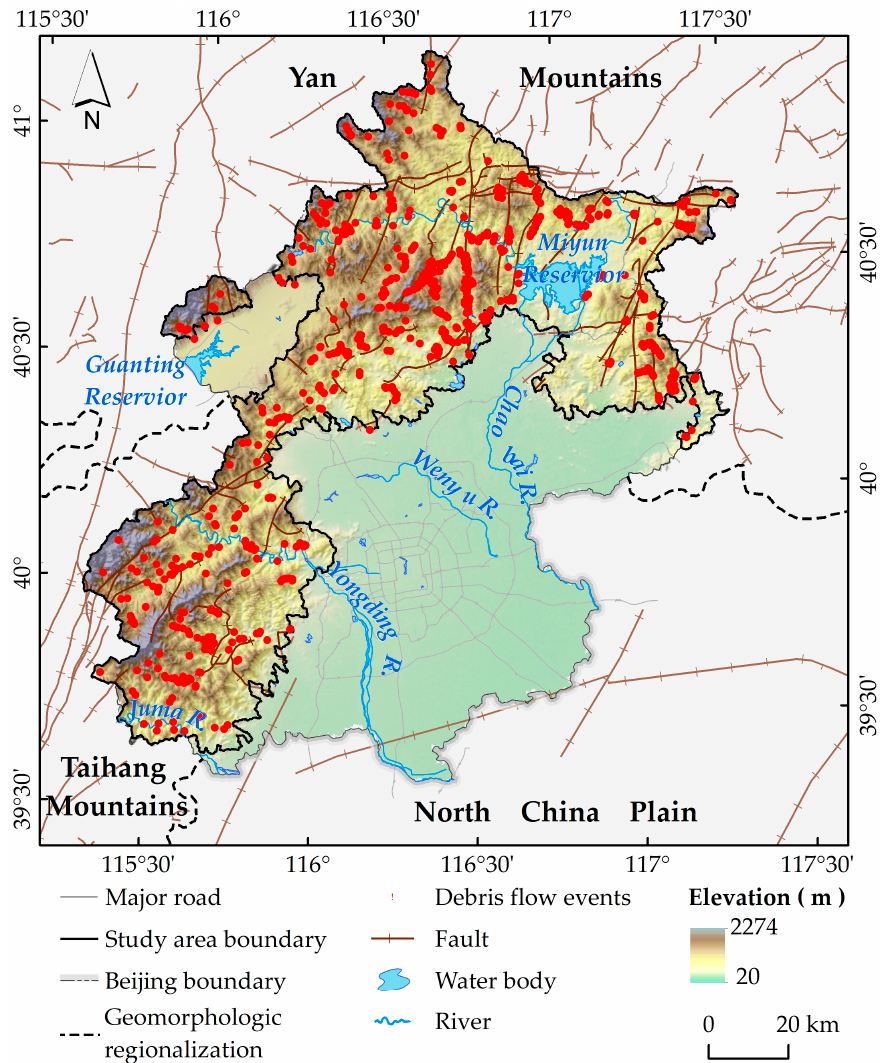
Figure 1. Geographical setting of the study area.